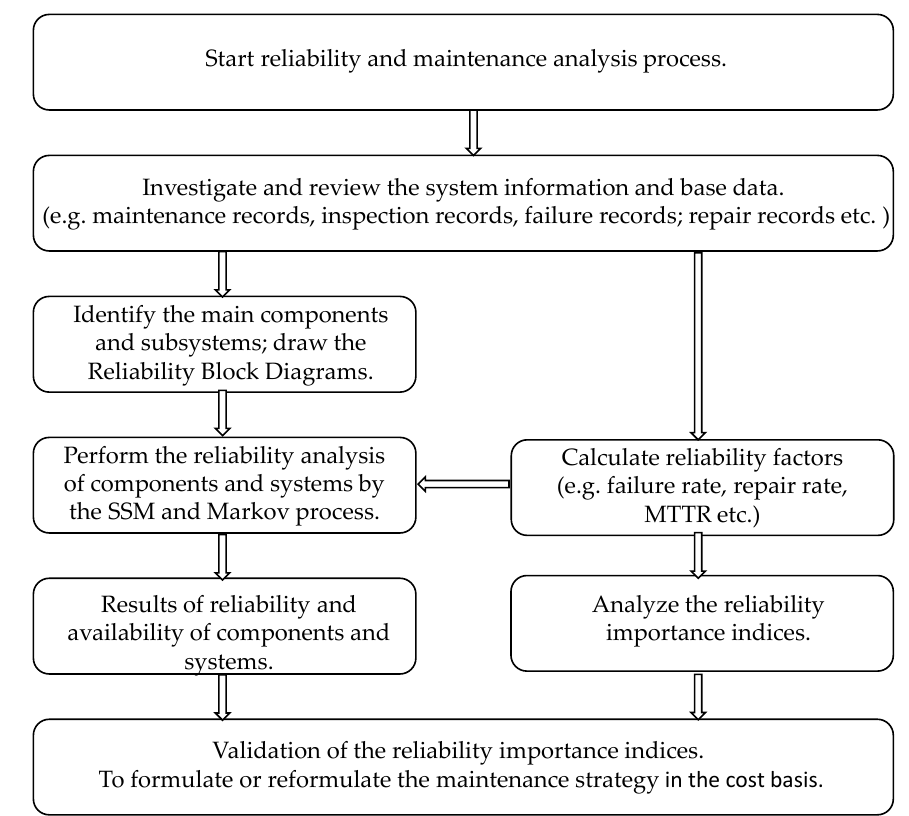
Figure 2. The research flowchart of reliability and maintenance prioritization analysis.